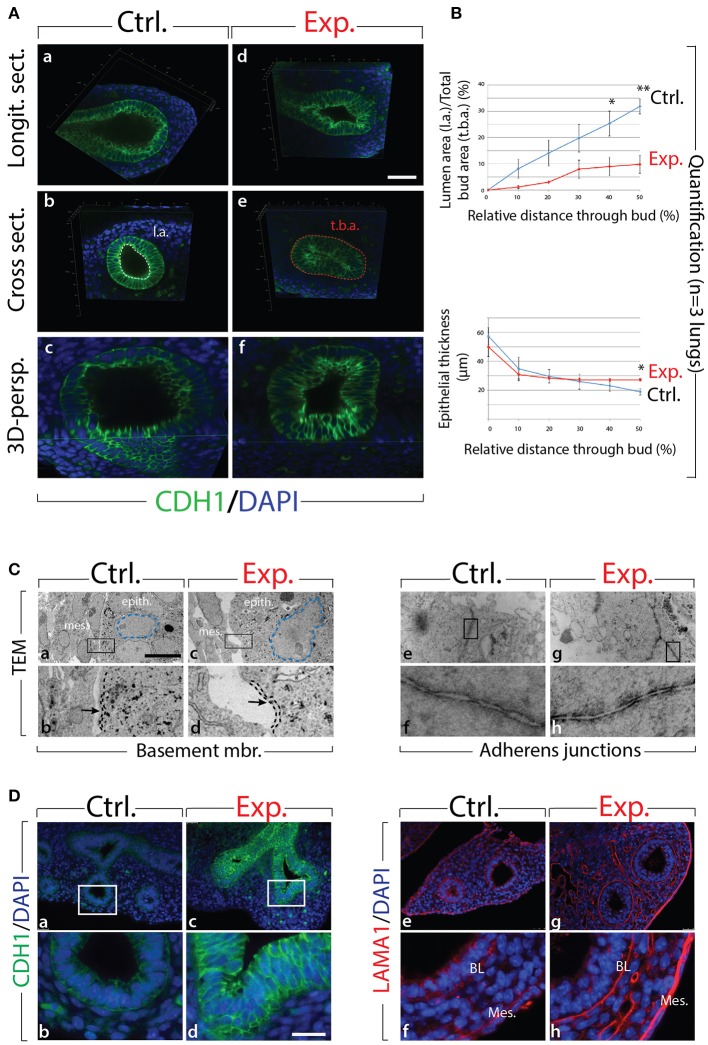
Inhibition of FGF10 activity for 9 h in E12.5 lungs leads to collapse of the epithelial bud associated with cell rearrangements and altered cell-cell adhesion (A) whole-mount confocal images of distal lung buds. Control buds show open lumens and an ordered epithelial monolayer (a–c), while experimental lung buds show collapsed lumens associated with multi-layered epithelium (d–f). Please note that due to our fluorescence acquisition requirements, the intensity of the signal cannot be compared between control and experimental samples. l.a. = lumen area; t.b.a. = total bud area. Scale bar: (a,b,d,e) 40 μm; (c,f) 16 μm. (B) Quantification of relative lumen area (l.a./t.b.a.) and epithelial thickness. (Data are presented as mean ± SEM; significance determined by unpaired two-tailed Student's t-test; n = 3; *p-value < 0.05, **p-value < 0.01). (C) TEM of distal lung buds highlighting the thickened basement membrane (black dashed line and arrows; a–d) and the darker staining around the adherens junctions (arrows; e–h) in experimental vs. control lungs. Note also the enlarged and irregularly shaped nuclei (blue dashed line; a,c) and the gaps between adjacent epithelial cells (asterisk; c,d) in experimental vs. control lungs. mes. = mesenchyme; epith. = epithelium. Magnification: (a,c) 7,750x; (e,g) 27800x; (b,d) 38,750x; (f,h) 139,000x. (D) Immunofluorescent staining for E-cadherin (CDH1) and laminin (LAMA1). E-cadherin shows increased expression in experimental lungs (c,d) compared to controls (a,b). Laminin deposition is increased in the basal lamina (BL) and mesothelium (Meso.) in experimental (g,h) vs. control lungs (e,f). Scale bar: (a,c) 75 μm; (b,d) 19 μm.